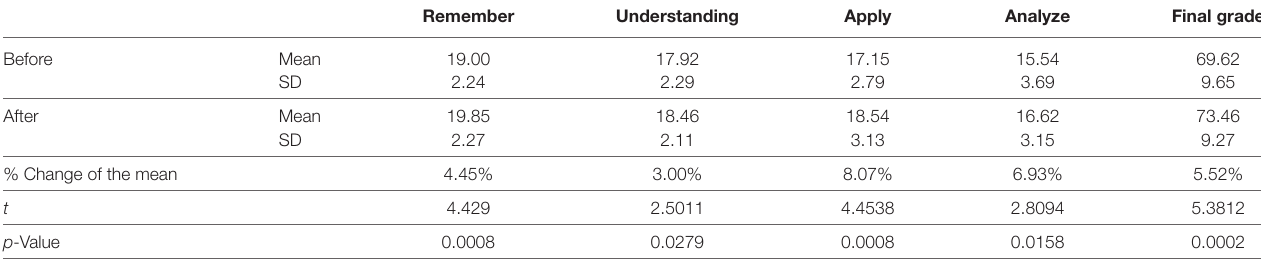
TaBle 5 | Students with high achievement in mathematics.